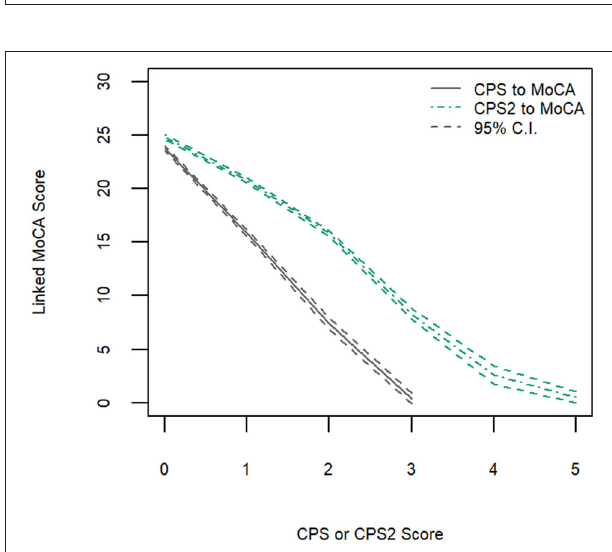
FIGURE 2 | Equipercentile linking function from CPS and CPS2 to MoCA-5min with 95% confidence